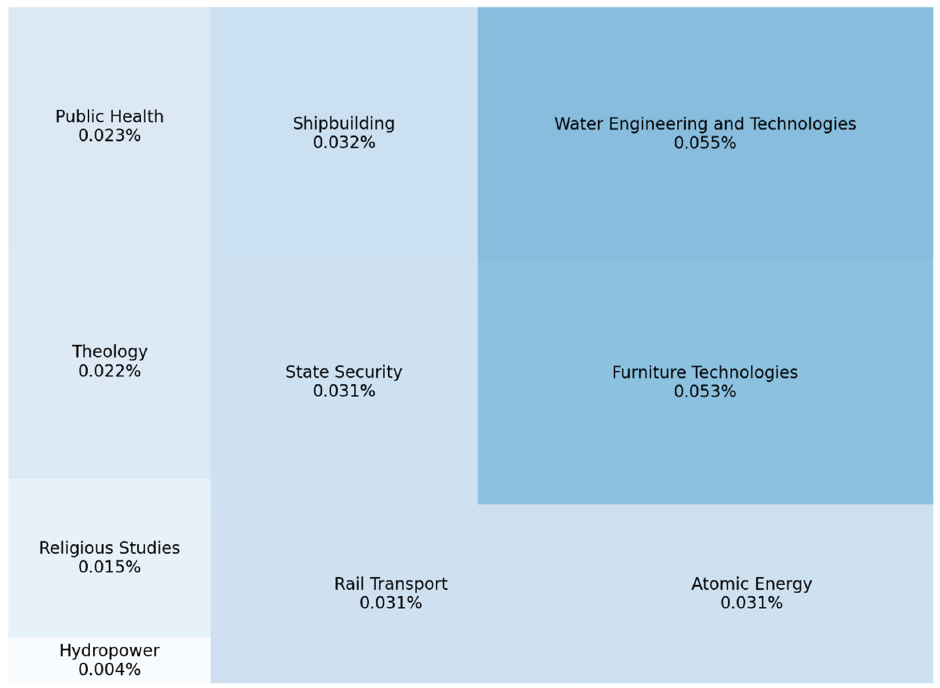
Figure 5. Top 10 least popular specialties among entrants during the 2021 admission